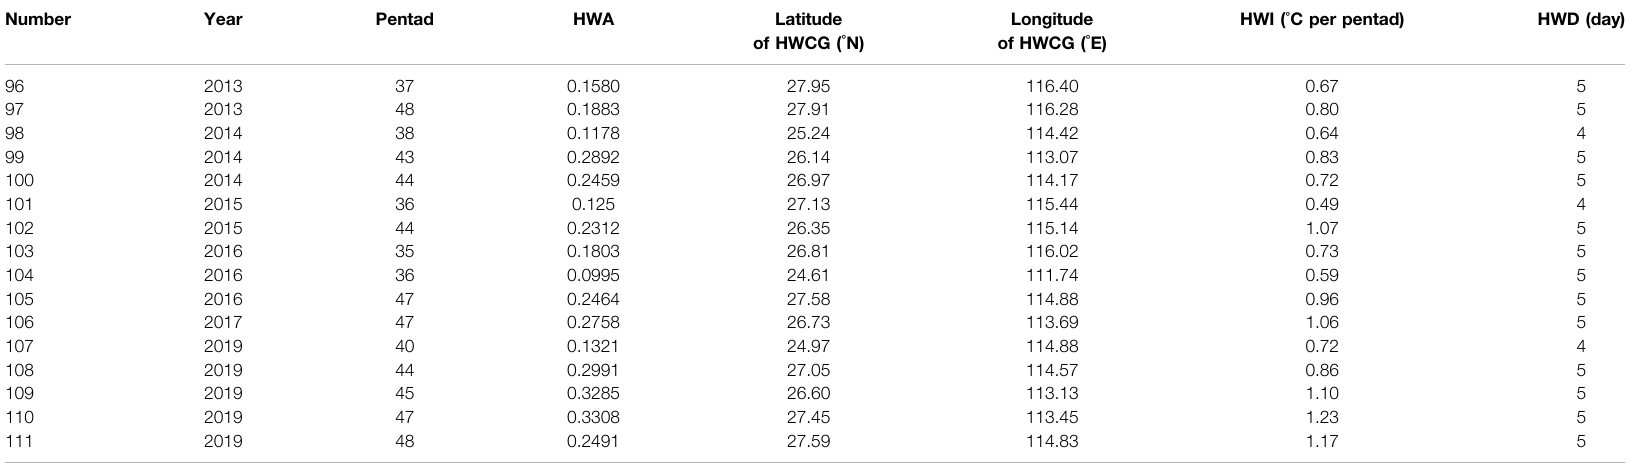
TABLE A3 | ( Continued ) Same as Table A2 , but for RPHWs in